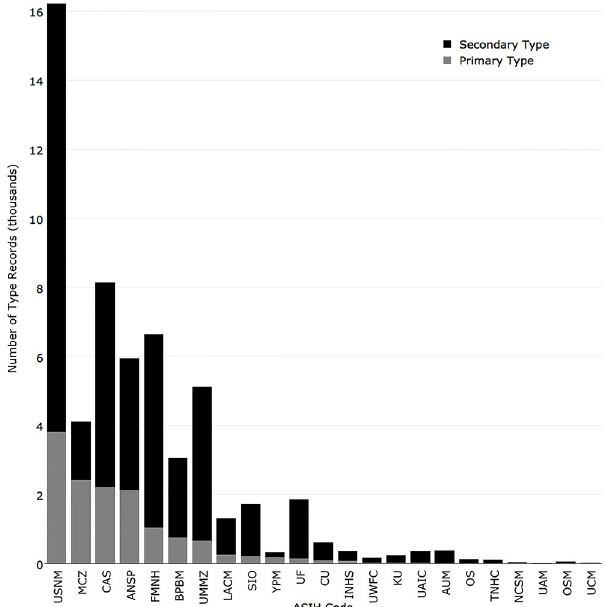
Fig 6. Number of type records returned for the 38 fish collections in iDigBio. Primary types are in light grey and secondary types are in black.